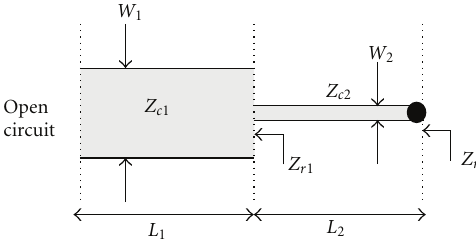
Figure 5: Description of the structure.